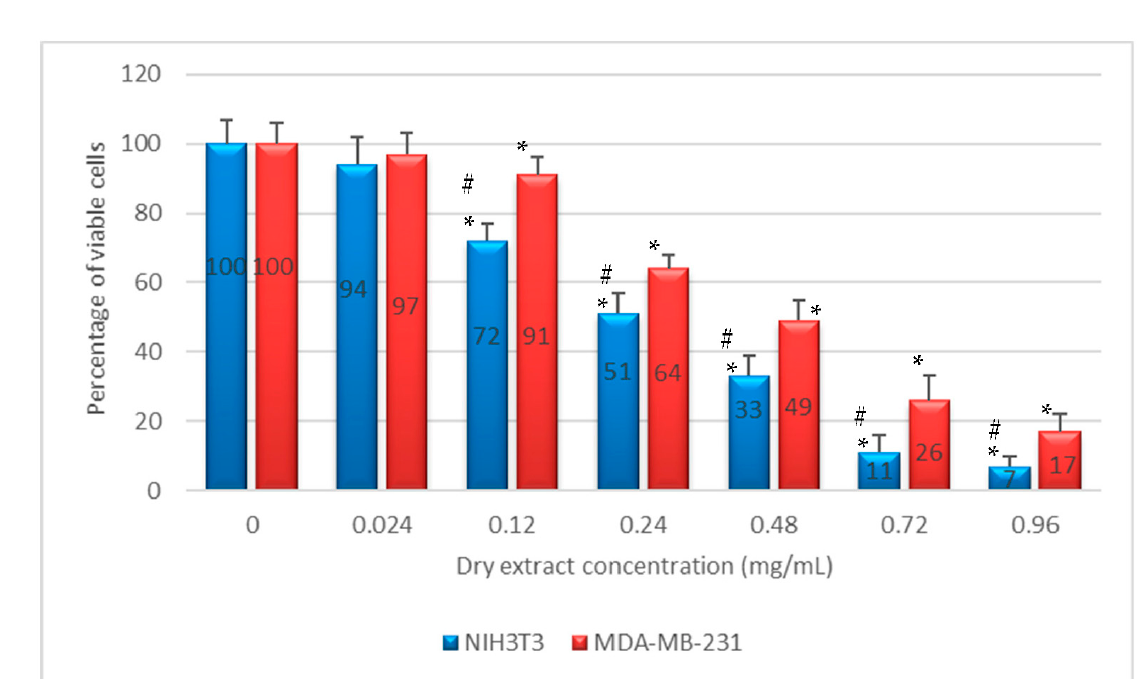
Figure 3. Percentage of viable NIH3T3 and MDA-MB-231 after 24 h of contact with increasing concentration of Ro ex dry extracts as determined by the Neutral Red Uptake. Date are mean ± SD of six replicates. * Values are statistically different versus negative control (complete medium), p < 0.05. # Values are statistically differently versus percentage of viable MDA-MB-231, p < 0.05.